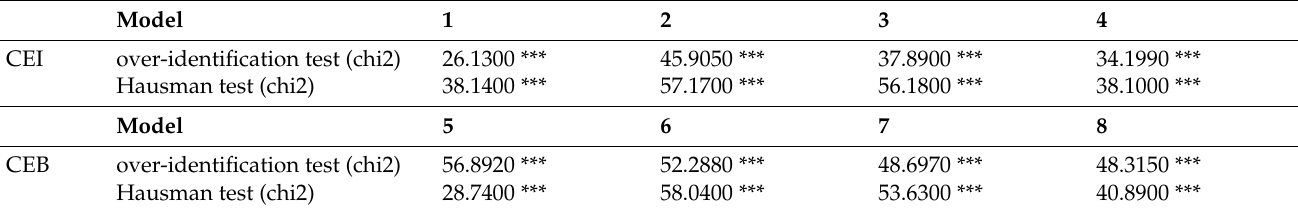
Table 2. Results of over-identification test and Hausman test.